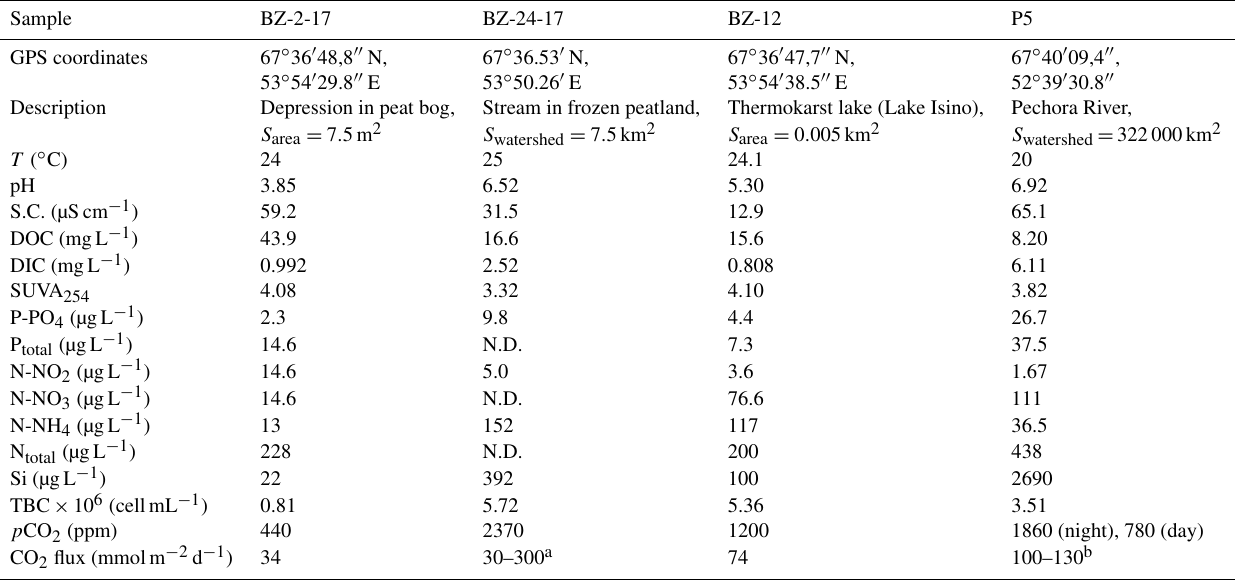
Table 1. Landscape setting, hydrochemical characteristics and CO 2 concentration, and emission flux of the waters studied. “S.C.” refers to specific conductivity, and “TBC” is total bacteria count (using the DAPI fluorescence